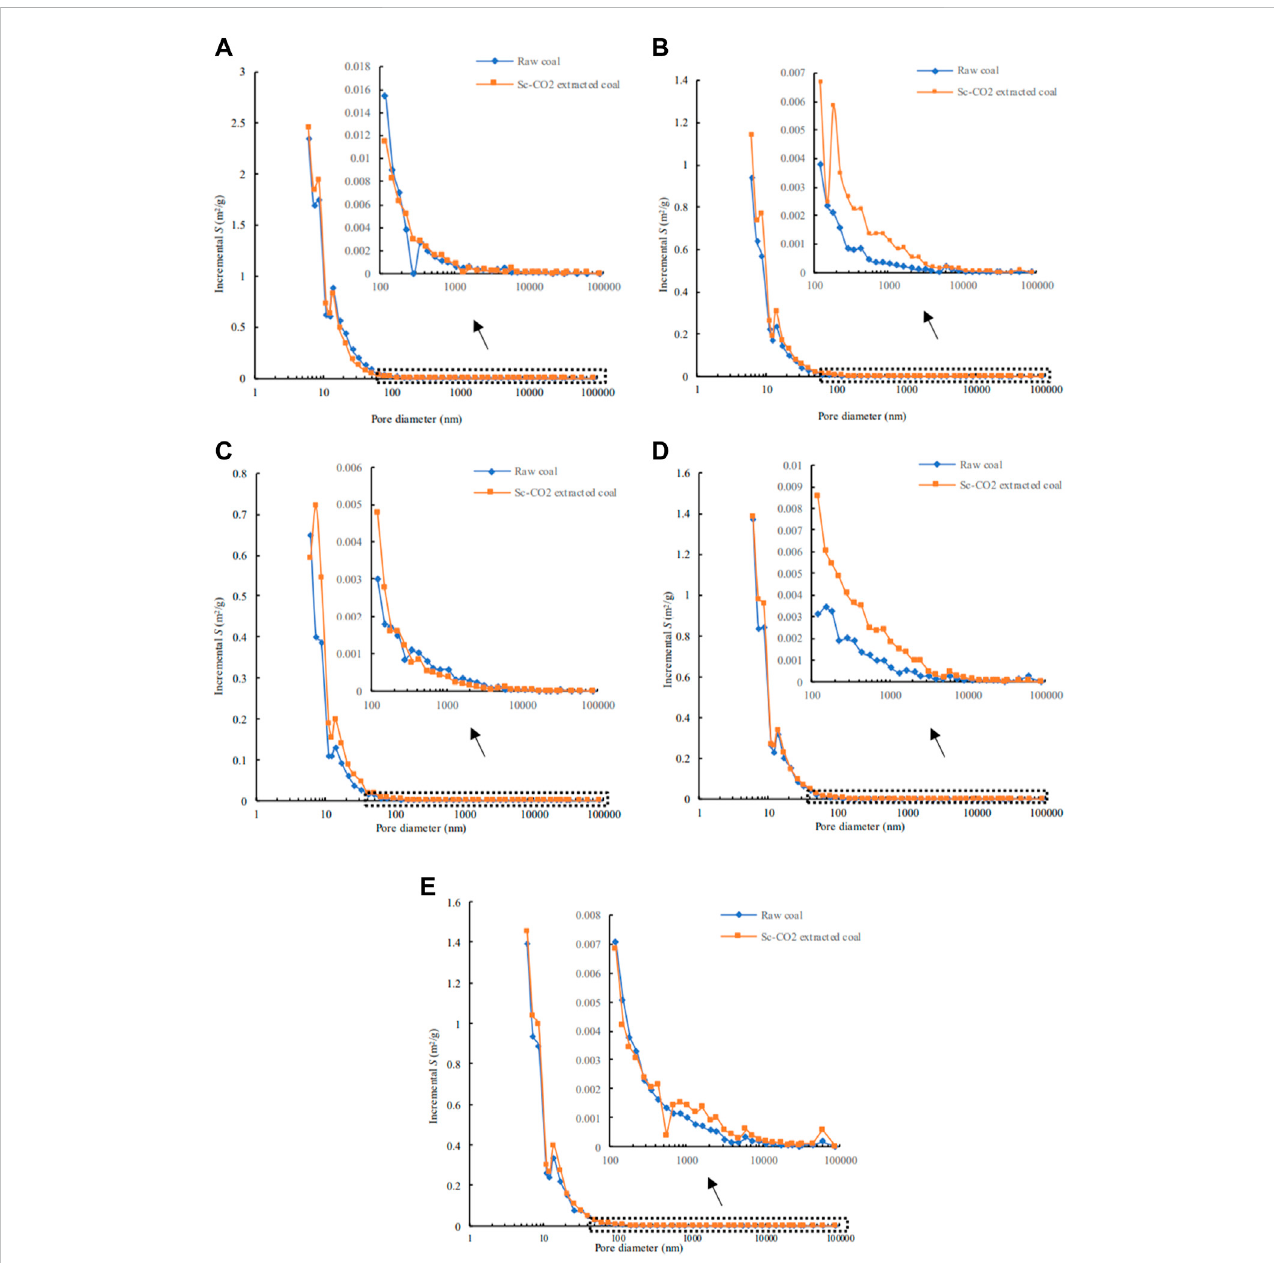
Pore-speci fi csurfaceareadistributionofthecoalsamplesbeforeandafterSc-CO 2 extraction (A) SJGcoal; (B) LJZcoal; (C) LLcoal; (D) CJWcoal;and (E) SSP coal.